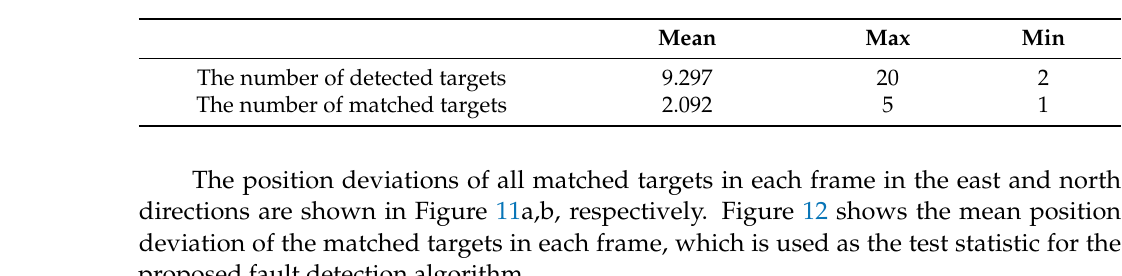
Figure 10. Matched targets between the single frame and map-based target detection results. ( a ) The No. 0–30 of matched targets for target detection in global map. ( b ) The number of detected and matched targets in each frame. Table 1. The number of detected and matched targets for single frame target detection.